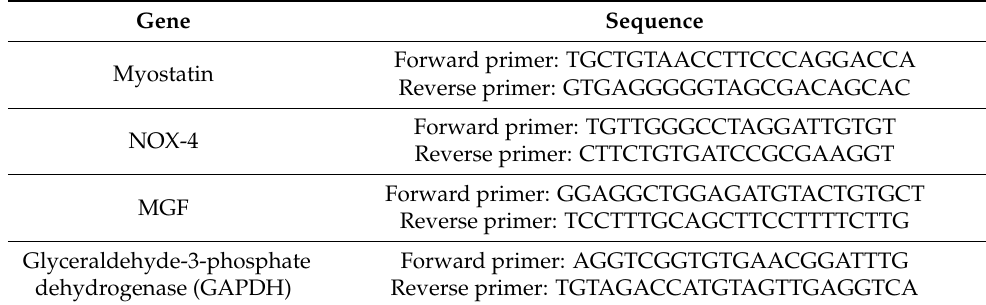
Table 2. The sequence of rat primers used in RT-PCR analysis. Gene